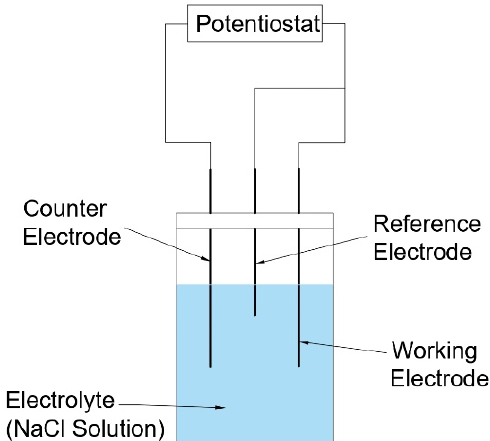
Figure 3. Schematic diagram of the three-electrode setup for electrochemical testing.